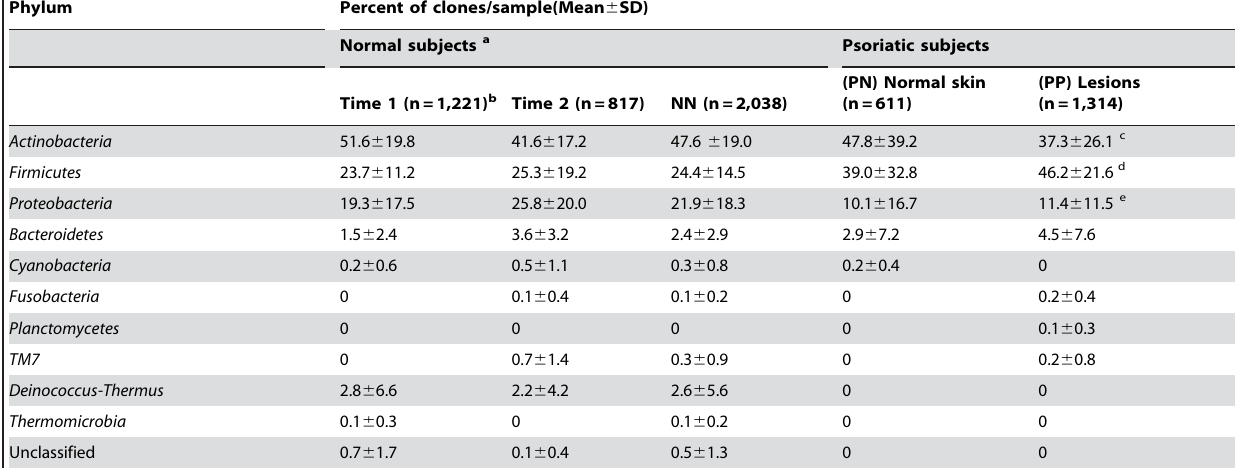
Phylum Percent of clones/sample(Mean 6 SD) Normal subjects